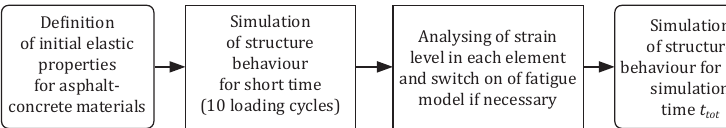
Figure 6. Simulation procedure for fatigue behaviour